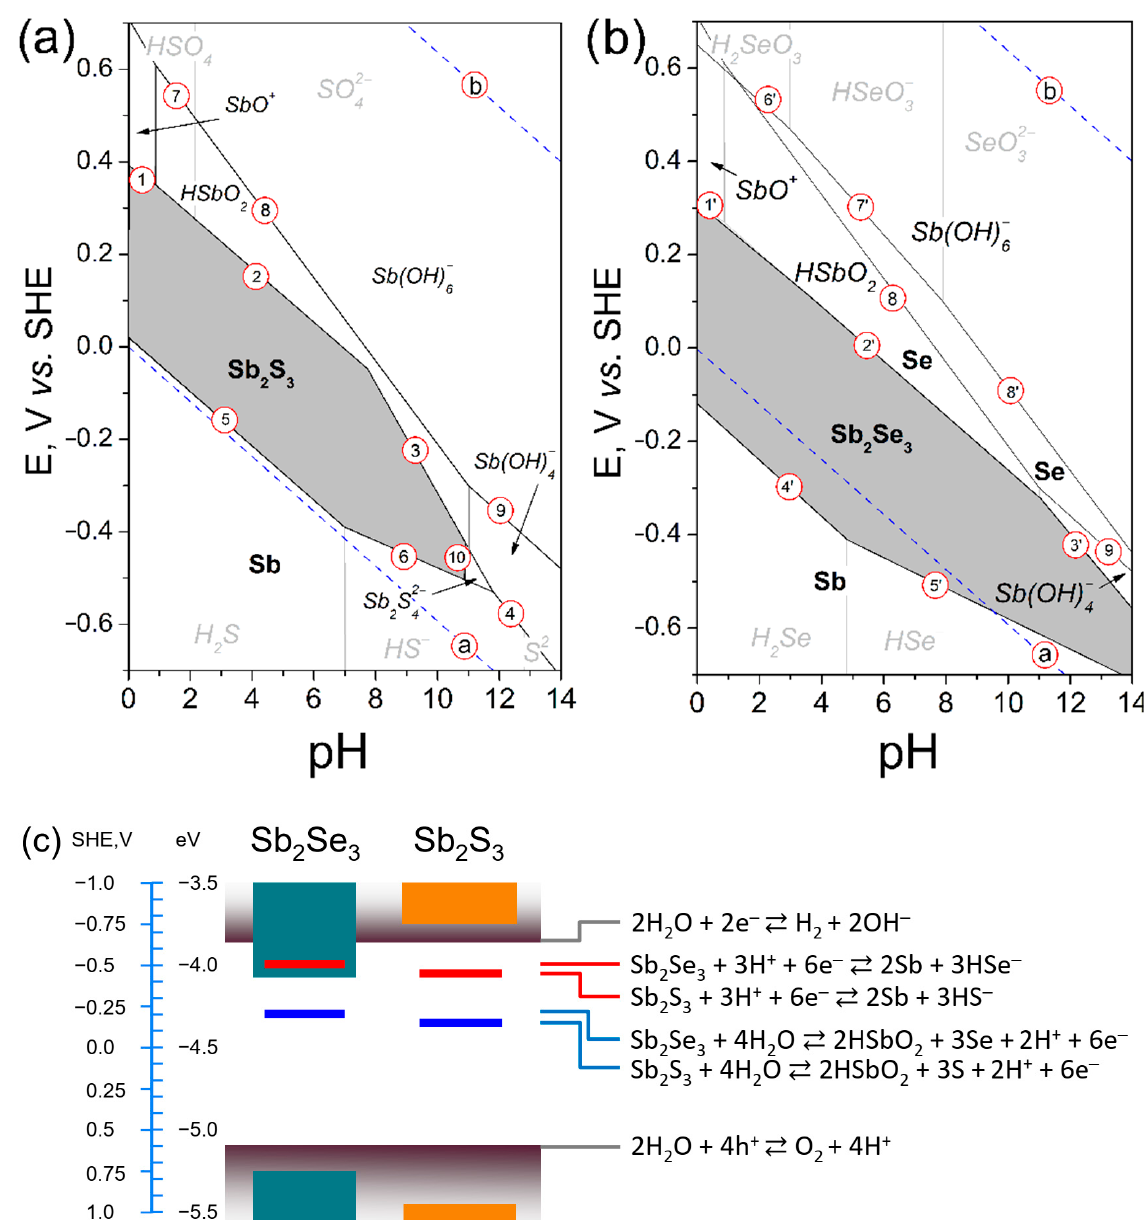
Figure 1. Potential-pH equilibrium diagrams for ( a ) Sb 2 S 3 -water and ( b ) Sb 2 Se 3 -water systems at 25 °C. The grey-filled areas correspond to the stability domains of Sb 2 S 3 and Sb 2 Se 3 . The lines represent equilibria between solid Sb 2 S 3 or Sb 2 Se 3 and reaction products. Encircled numbers refer to the reactions listed in Table S1 (see SI). The ( a , b ) dashed lines correspond to the stability region of water. ( c ) Proposed decomposition scheme for Sb 2 S 3 or Sb 2 Se 3 in aqueous solutions.